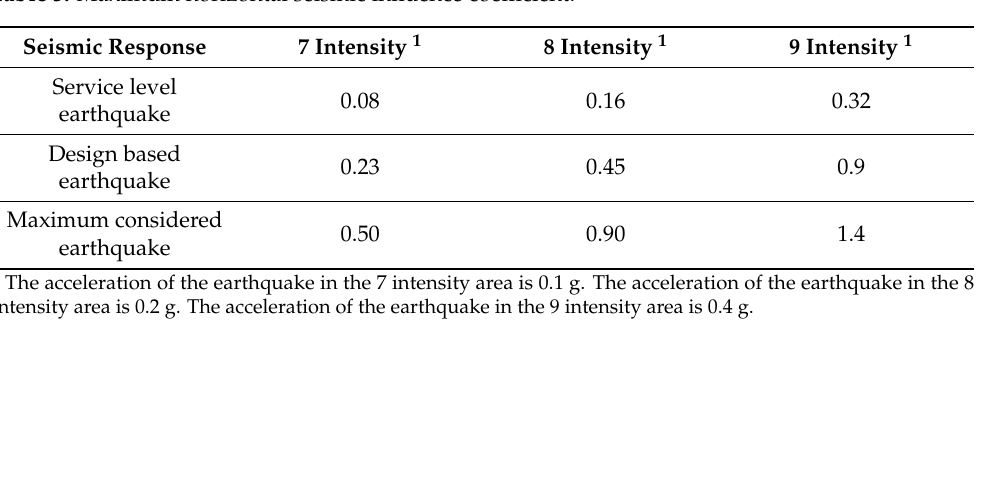
Table 3. Maximum horizontal seismic influence